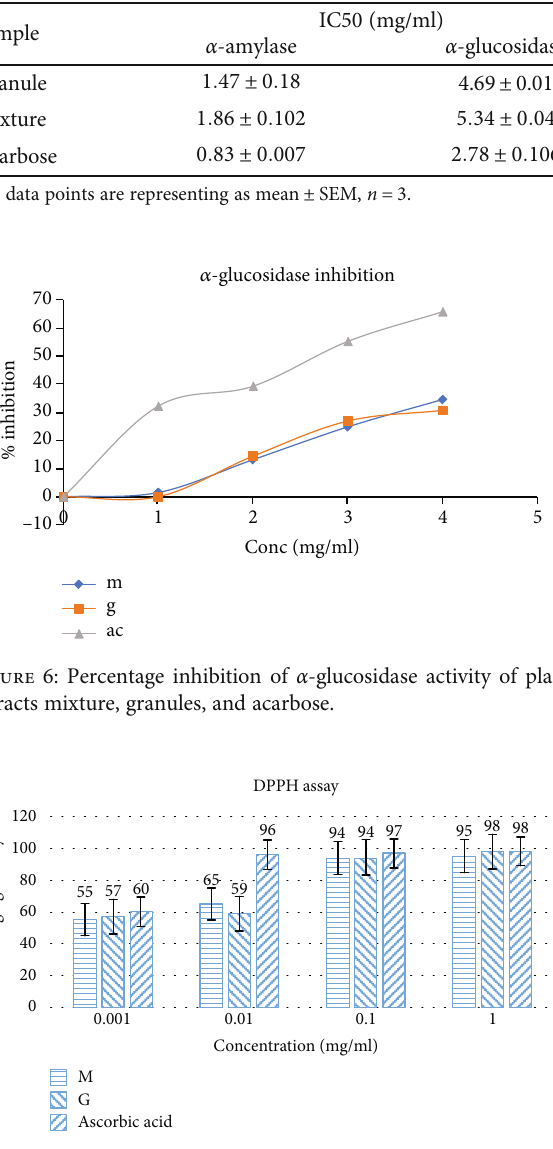
Figure 7: DPPH radical scavenging activity of mixture, granules, and ascorbic acid. The data points are represented as mean ± SEM , n = 3